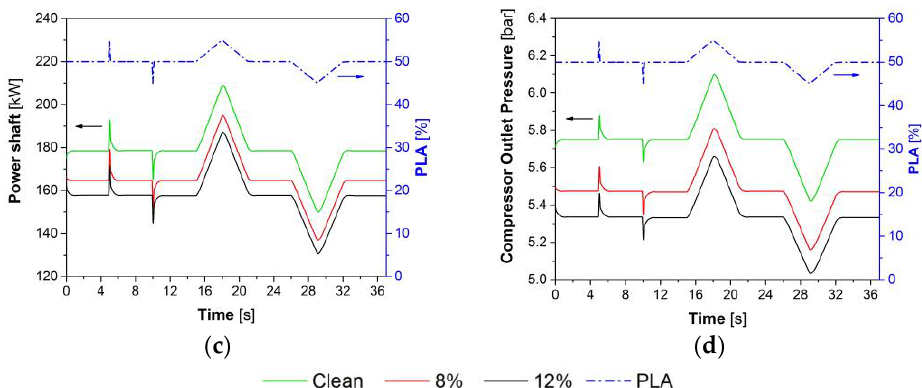
Figure 4. Comparison between the GSP and linear model output variables. ( a ) Exhaust gas temper- ature; ( b ) shaft speed; ( c ) shaft power; ( d ) compressor outlet pressure. The black arrow indicates the primary axis variables; the blue arrow refers to the secondary axis (PLA).